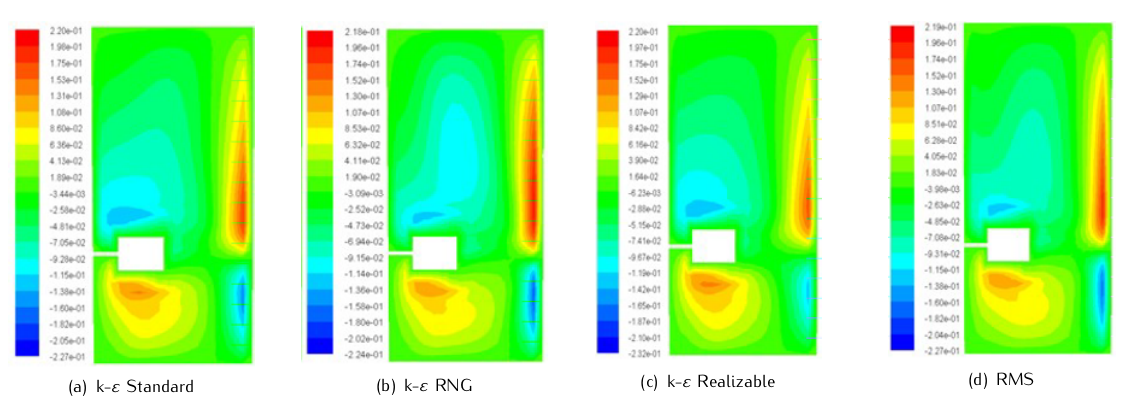
Figure 5. Distribution of the axial velocity in r-z